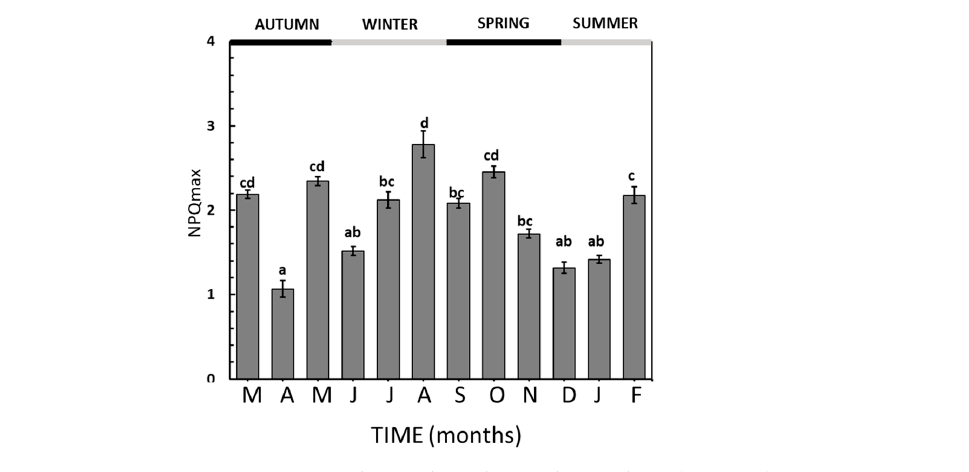
Figure 7. Maximal non-photochemical quenching (NPQ max ) in L. spicata measured at Cochoa Beach, Viña del Mar, Chile, between autumn and summertime. Letters indicate significant differences after the SNK test ( p < 0.05).